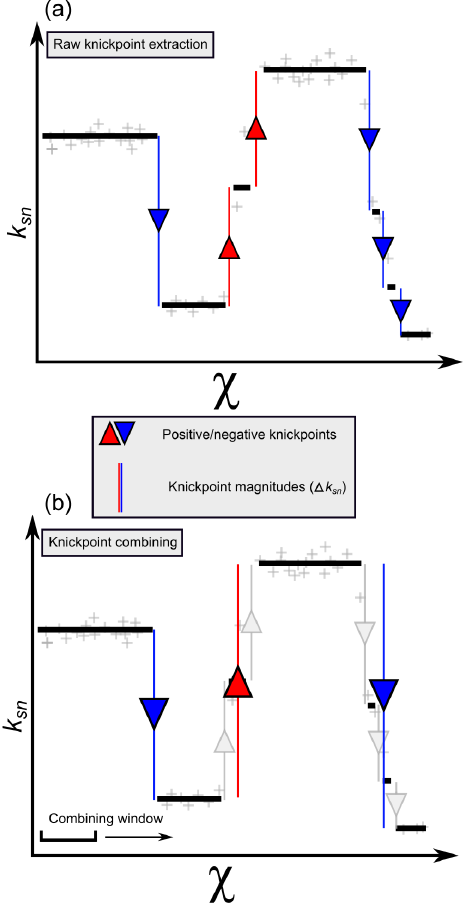
Figure 4. Knickpoint extraction from the denoised k sn